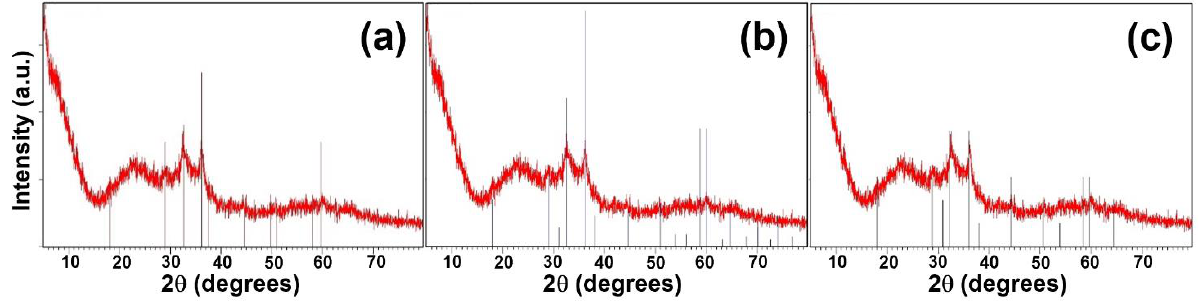
Figure 5. High-angle XRD pattern of the Mn-nanozyme compared to the patterns of ( a ) Mn 2 O 3 (JCPDS file nº 00-006-0540), ( b ) Mn 3 O 4 (JCPDS file nº 00-001-1127), and ( c ) MnSiO 3 (JCPDS file nº 00-012-0181).